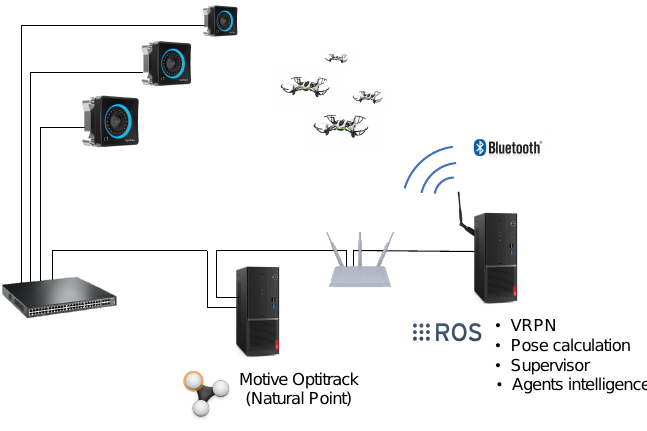
Figure 11. General scheme of the experiment’s